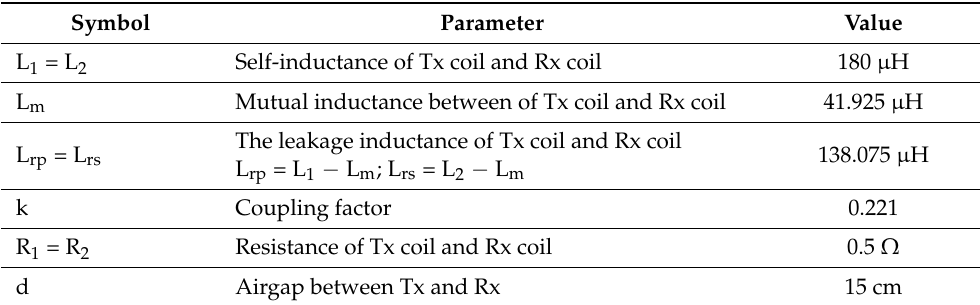
Table 3. Transmitter (Tx) and receiver (Rx) parameters.